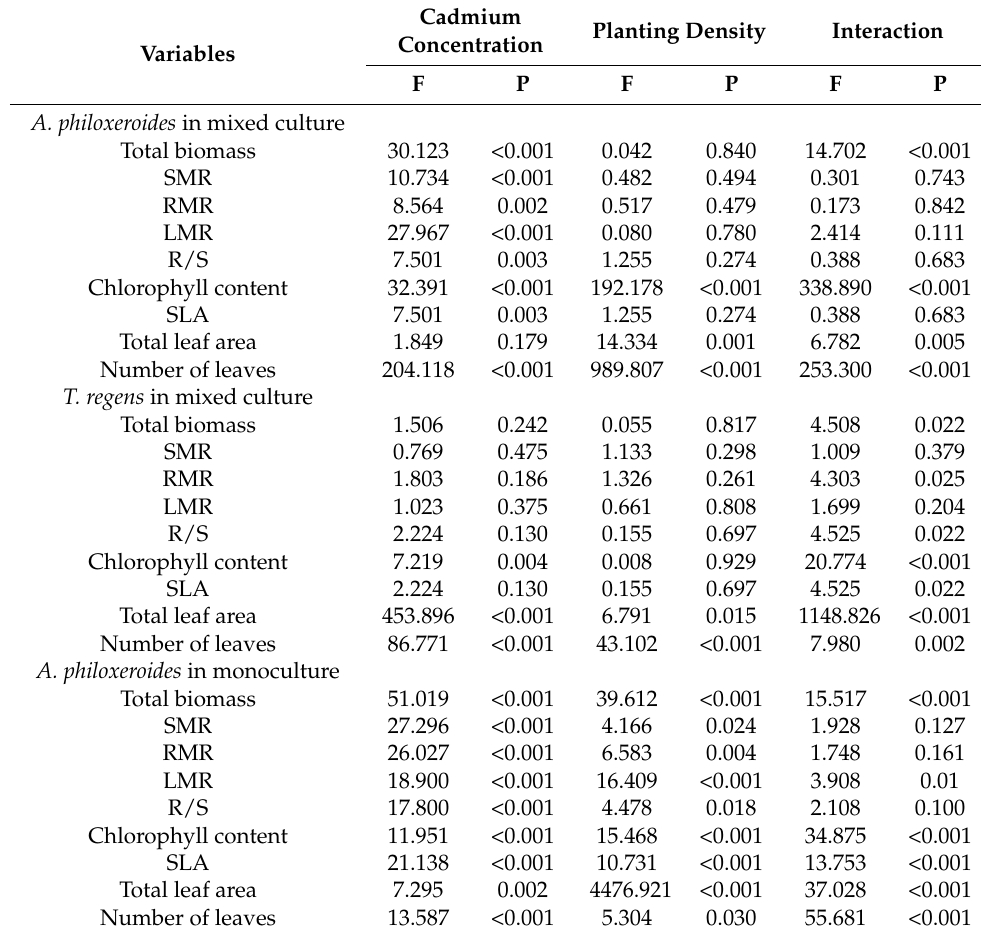
Table 1. F-values and significance levels for factorial ANOVA of the effects of density and cadmium on morphological traits and biomass of A. philoxeroides and T. regens . Cadmium Planting Density Concentration Variables